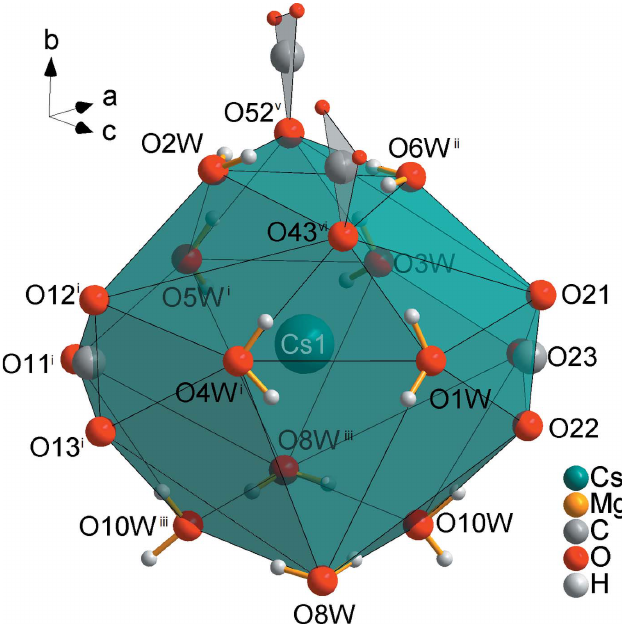
[Mg(H O) (CO ) ] 1 2 2/1 3 3/3 O) (CO ) ] 2– units form 2 3 3 2